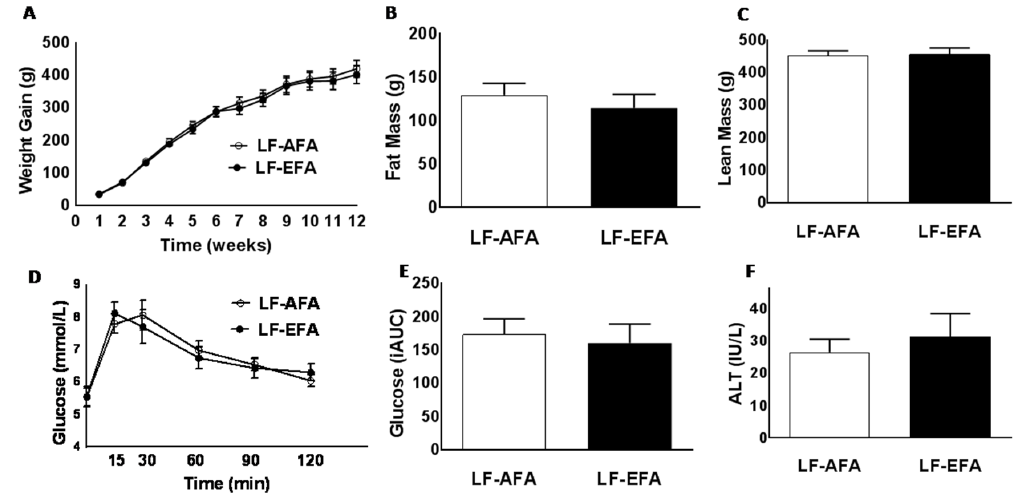
Figure 1. Excess folic acid intake does not influence body weight, body composition or glucose tolerance on a low fat diet ( A ); growth curves ( B ); fat mass ( C ); lean mass ( D ); glucose tolerance ( E ); area under the glucose curve, and ( F ) plasma ALT, of rats fed 15% LF diet with excess or adequate folic acid. Values are means ± SEM, * p < 0.05.